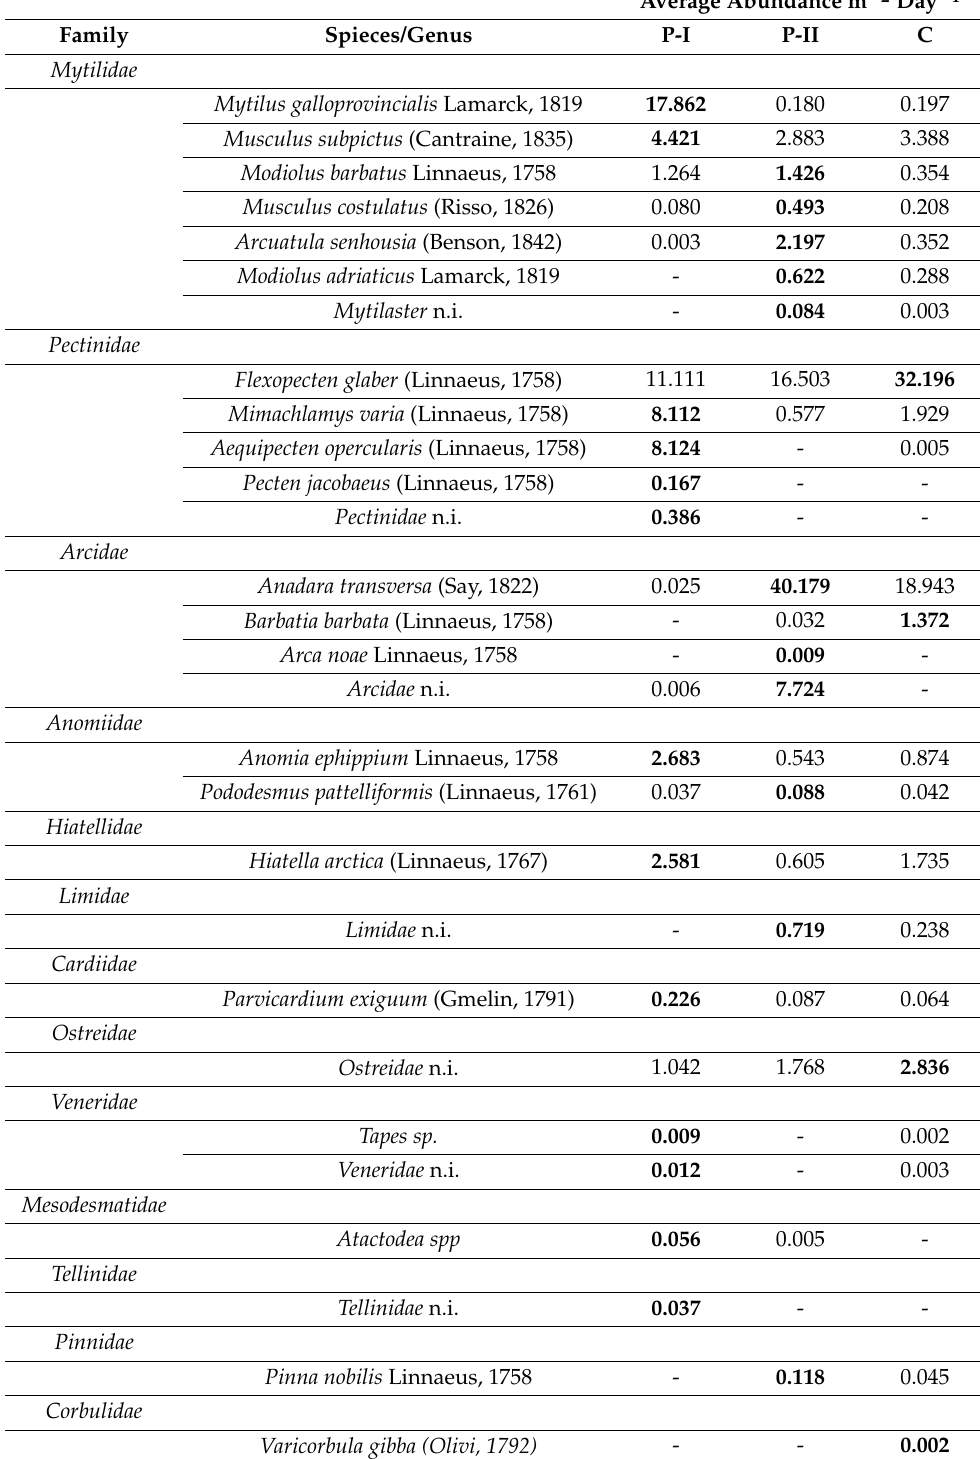
Table 2. List of total bivalve recruits and their relative abundance (m − 2 day − 1 ), collected by net bags deployed in spring–summer in Pellestrina (PI) and in summer–autumn in Pellestrina (PII) and Caleri (C). n.i. not identified species. For each taxon the most abundant recruitment is in